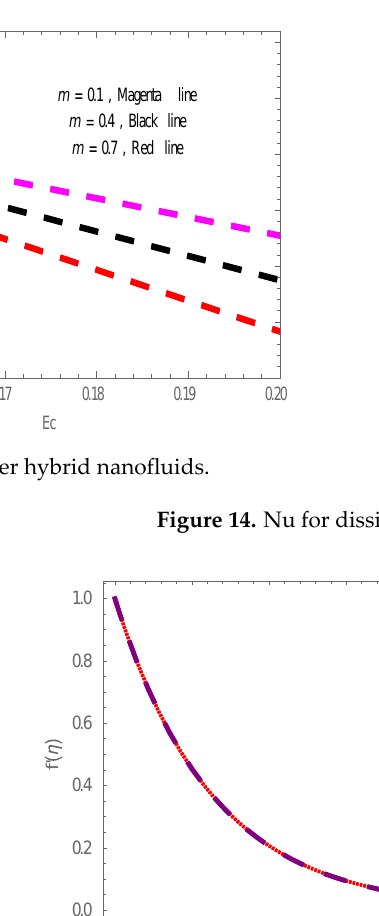
Figure 13. Nu for dissimilar values of R .